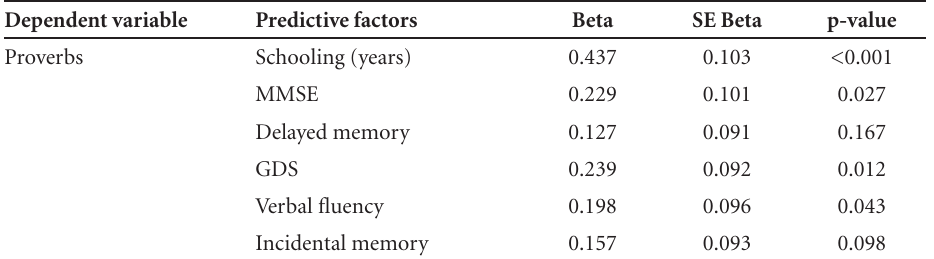
Table 5. Multivariate linear regression analysis by Stepwise Forward model (p<0.20), for Proverb Test scores including sociodemographic and cognitive